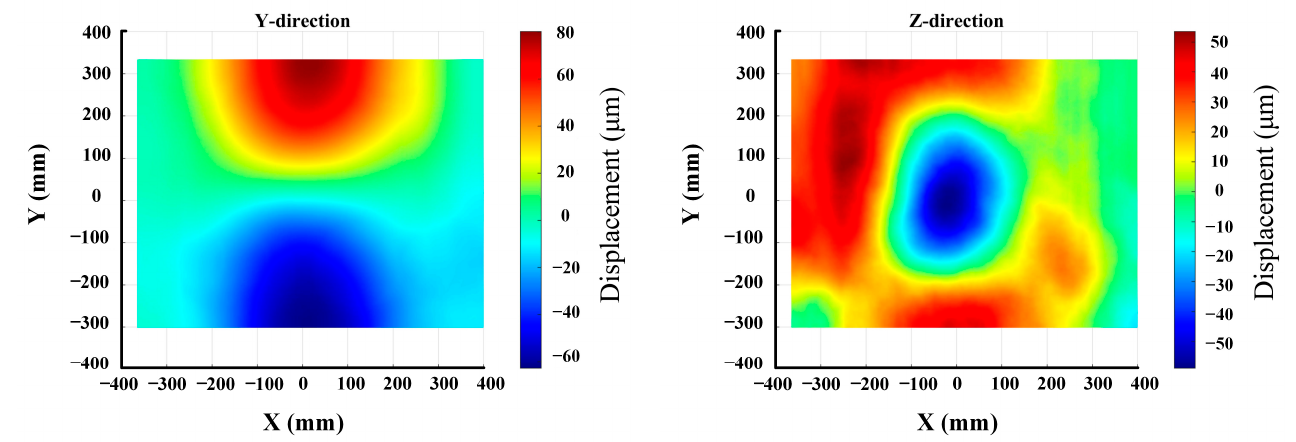
Figure 9. Three-dimensional displacement obtained by the measurement system.